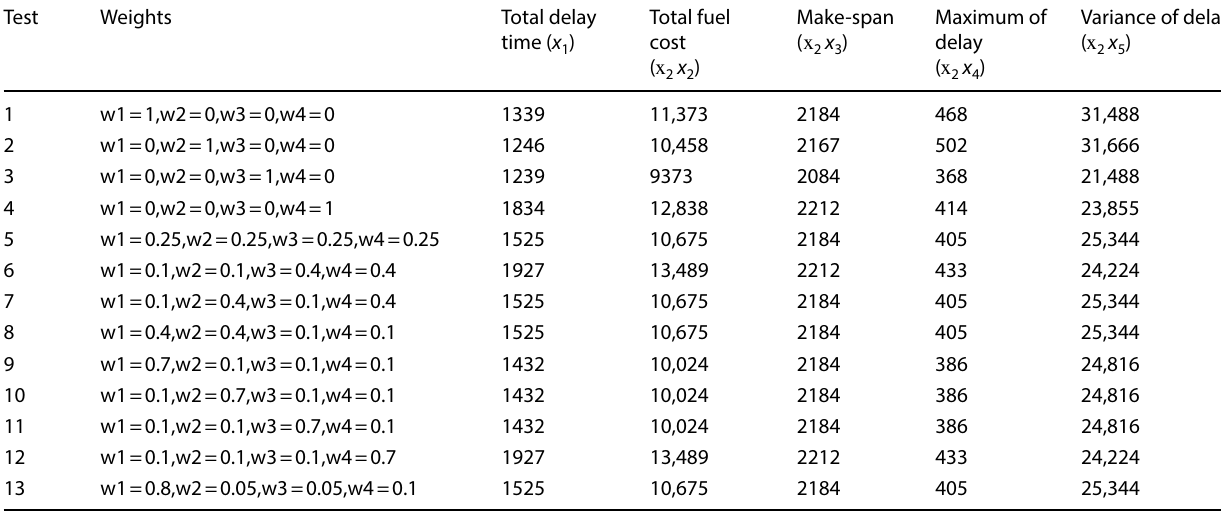
Table 3 Using FCFS to calculate performance indicators when the weights take the following value